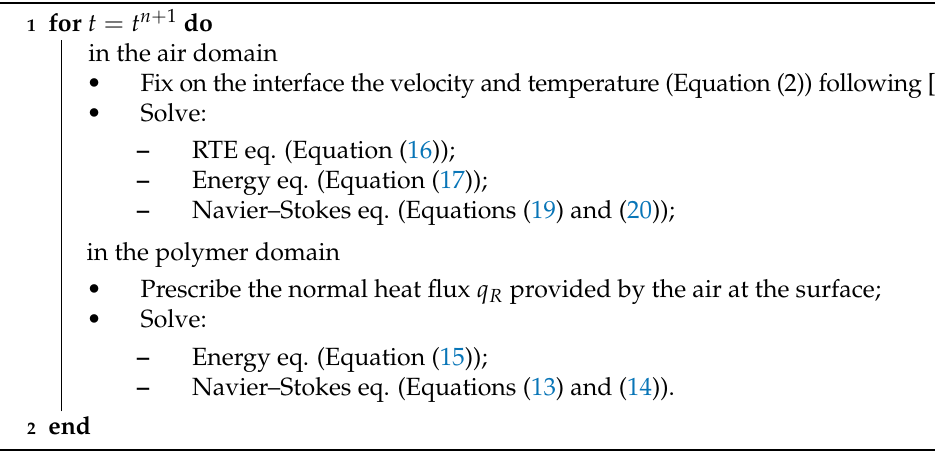
Algorithm 1: Solution algorithm for the simulation of the UL 94